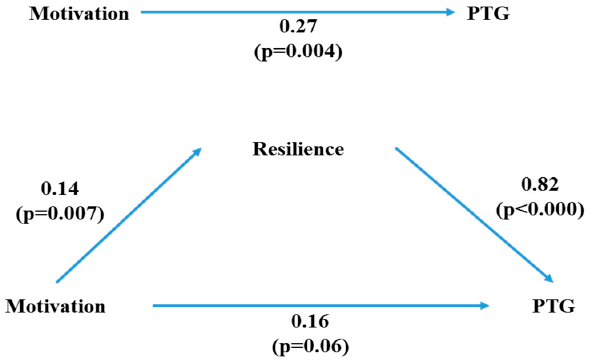
Figure 1. Resilience mediation models of the relationship between academic motivation and post-traumatic growth. All Steps included age, gender, school year, self- reporting economic status, grade point average, stress level of clinical practice, satisfaction with ones’ major and satisfaction with university life as covariates.